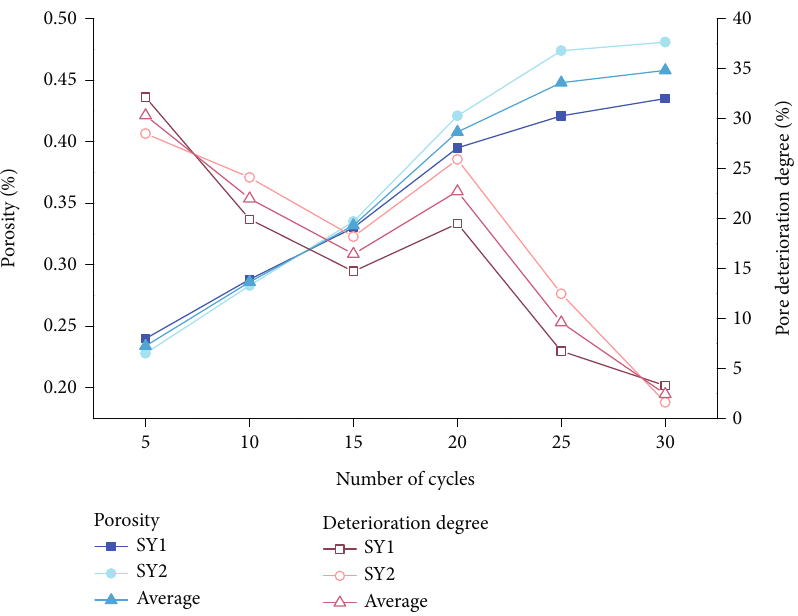
Figure 2: The variation law of porosity and deterioration degree.